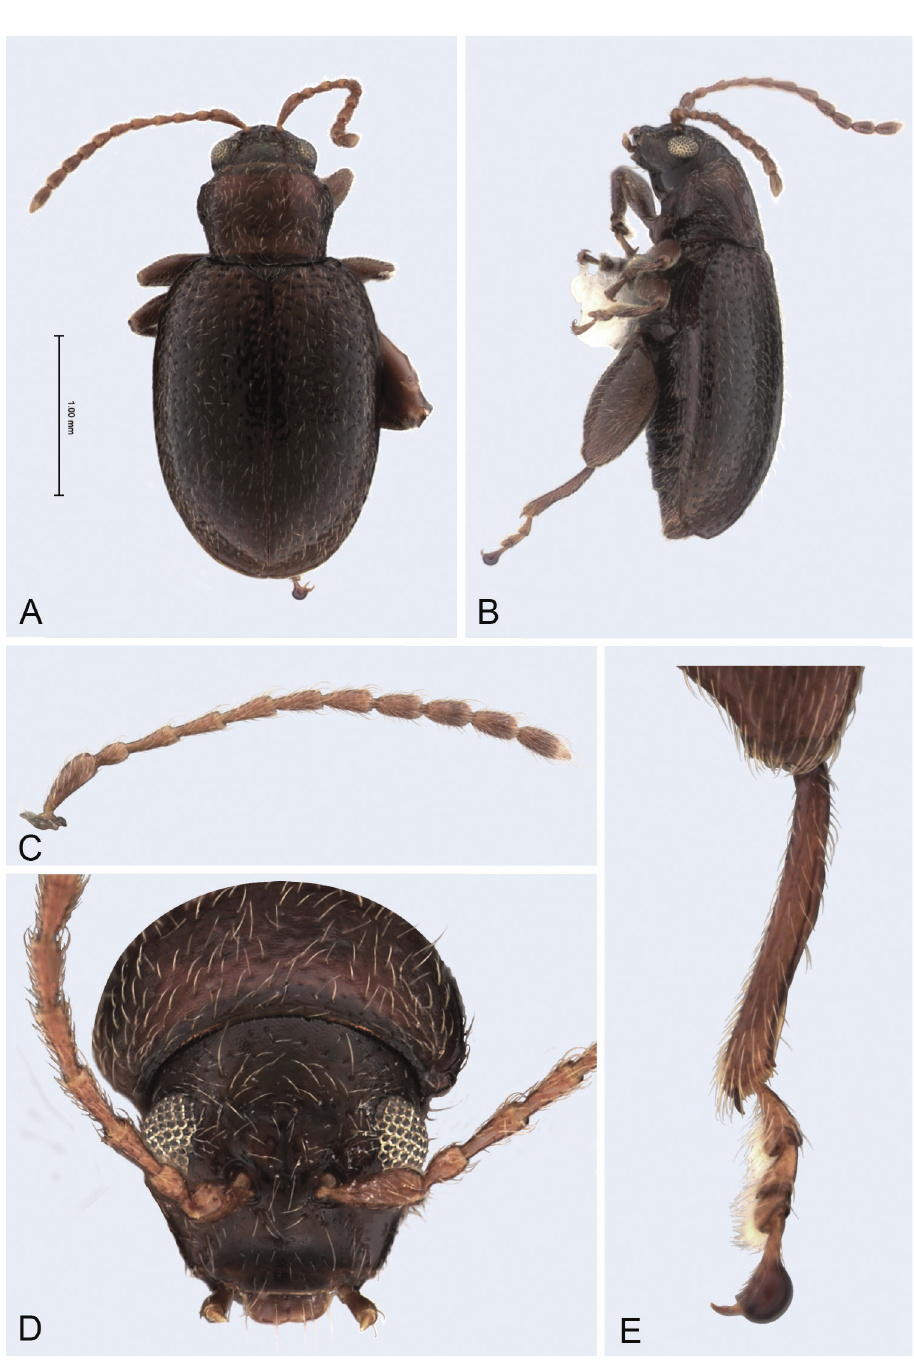
Figure 17. Andersonoplatus macubaji . A Habitus dorsal B Habitus lateral C Antenna D Head, frontal view E Hind